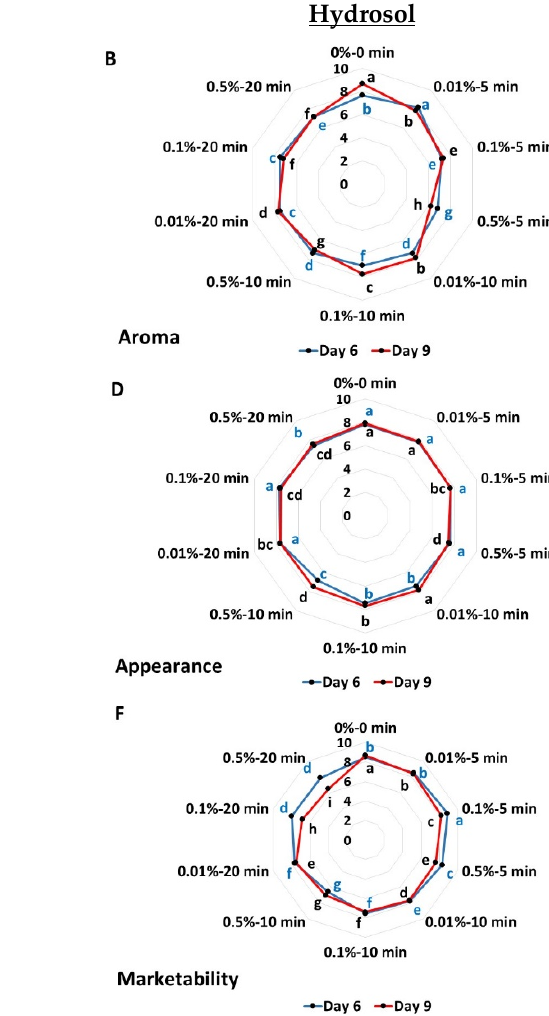
Figure 3. Screening of O. dubium EO ( A , C , E ) and hydrosol ( B , D , F ) application effects on sensory attributes (aroma, appearance and marketability) of tomato fruit stored at 11 °C for 12 days. Differ- ent Latin letters indicate significant differences at p < 0.05.